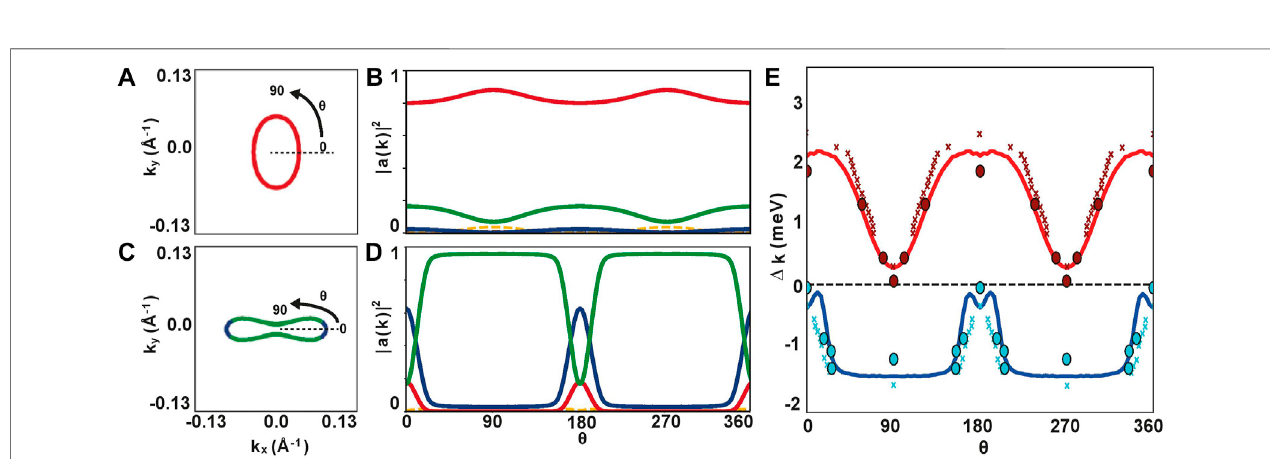
FIGURE9| TheoreticalsimulationofthemomentumdependenceofthesuperconductinggapfromRhodes et.al. [19].Here,aFermisurfaceconsistingofonehole pocket a single electron pocket were considered and a spin fl uctuation pairing mechanism was assumed. (A,B) Fermi surface of the hole pocket and angular dependence of the orbital content of the hole pocket. (C,D) Fermi surface of the one electron pocket and angular dependence of the orbital content of the electron pocket. The colour labels are red d xz , green d yz and blue d xy . (E) Simulated angular dependence of the superconducting gap for the hole pocket (red) and electron pocket (blue), revealing a direct correlation with the d yz weight shown in (B) and (D) . The crosses and dots are experimental data extracted from STM [15] and ARPES [19] measurements respectively.